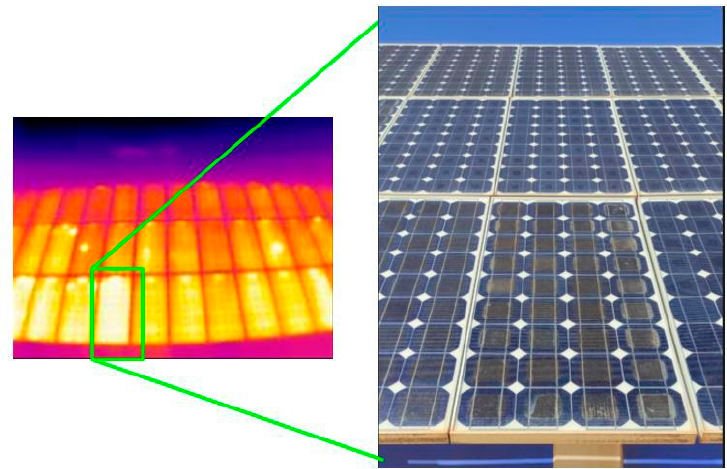
Figure 15. Image with a damaged PV panel.